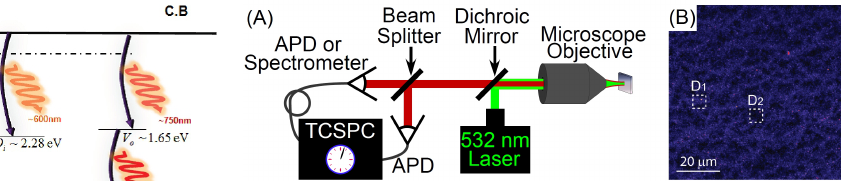
Figure 2: (A) Schematic of confocal microscope used to probe sin- gle defects. Sub-bandgap energy green light excites local defect states and the subsequent emission is detected by an APD sensitive to single photons or by a spectrometer. A TCSPC module enables measurement of g 2 ( τ ) for verification that a single defect is being studied. (B) Typical scanning confocal fluorescence map of ZnO illu- minated with 532 nm continuous wave light. Locations marked “D1” and “D2” identify SPSs. Reproduced with permission from Ref. [10] (A) and [9] (B). APD: avalanche photodiode; TCSPC: time-correlated single-photon counting; SPSs: single-photon